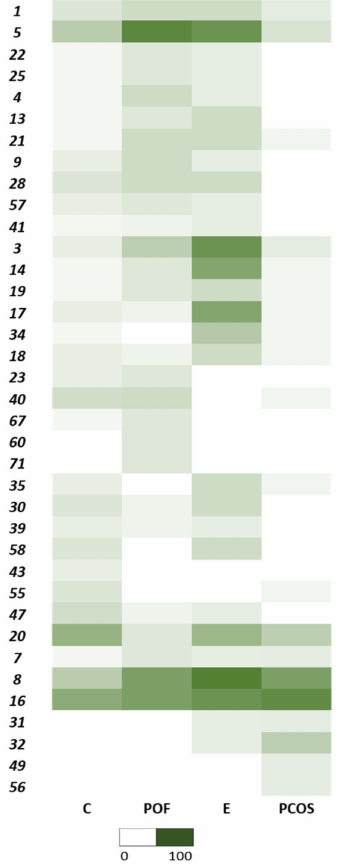
Figure 3. Percentual occurrence of VOCs in all the samples for each medical condition. The ab- scises correspond to: (C) controls; (POF) premature ovarian failure; (E) endometriosis; (PCOS) polycystic ovary syndrome. The coordinates represent the VOCs considered, which were as- signed numbers: (1) palmitic acid; (3) tetradecanal; (4) 2,4-di-tert-butylphenol; (5) diethyl phthalate; (7) 1,2,3,4-tetramethylbenzene; (8) 4-methyl-2,4-bis(4-hydroxyphenyl)pent-1-ene; (9) palmitic acid ME; (13) isopropyl myristate; (14) octadecanal; (16) tetradecamethylcycloheptasiloxane; (17) hexade- canal; (18) gam-ma-stearolactone; (19) dodecane; (20) dodecamethylcyclohexasiloxane; (21) hexade-